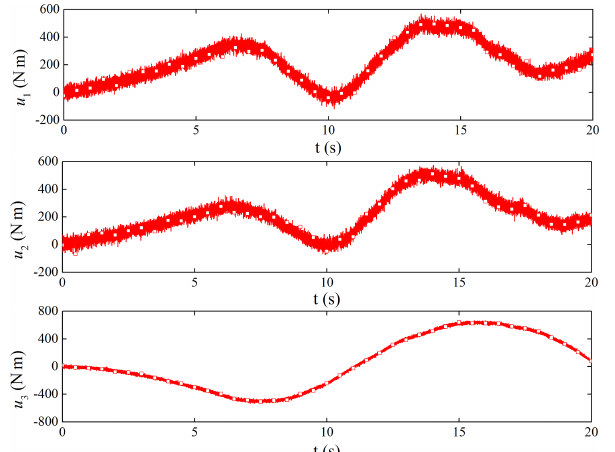
Figure 13. Tension of booms.